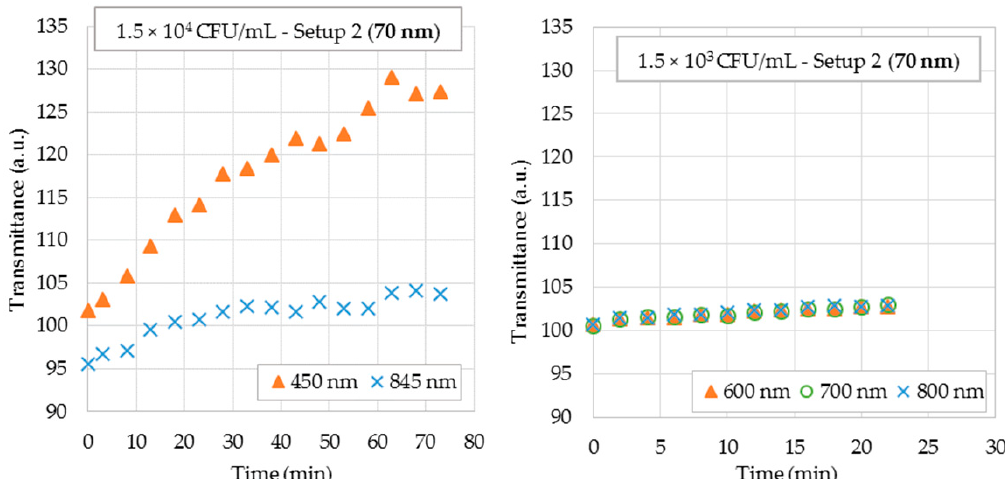
Figure 10. Sensor responses for bacterial suspensions using Setup 2. ( a ) 70 nm gold-coated biosensors in a 1.5 × 10 4 CFU/mL bacterial suspension; ( b ) 70 nm gold-coated biosensors in a 1.5 × 10 3 CFU/mL bacterial suspension.